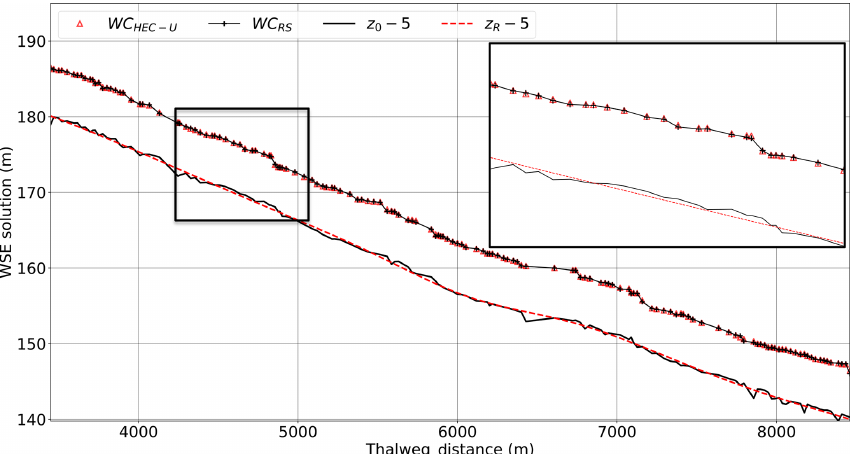
Figure 16. Comparison of SPRNT-RS to unsteady HEC-RAS for water surface elevations in Waller Creek simulations with expanded detail to show similarities. For clarity, 5m is subtracted from the channel z